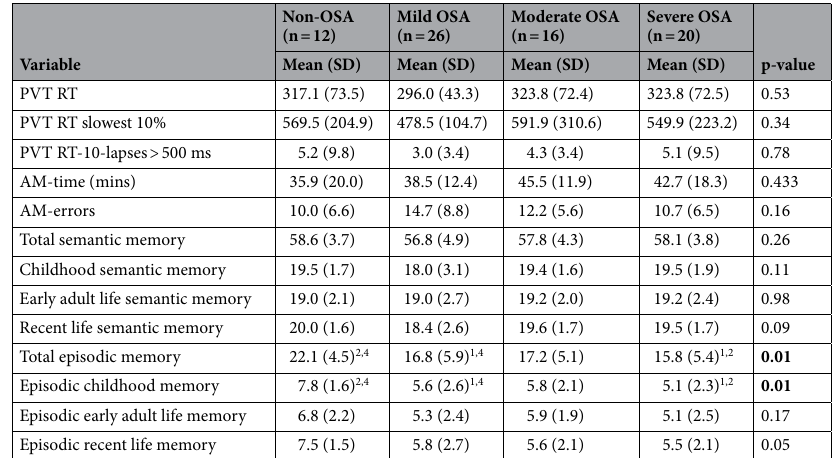
Table 2. Comparison of cognitive tests by OSA severity group. OSA severity cut-off values were: 5–14 AHI (mild); 15–29 AHI (moderate); ≥ 30 AHI (severe); Significant differences between groups were defined by: 1 p < 0.05 vs. non-OSA; 2 p < 0.05 vs. mild OSA; 3 p < 0.05 vs. moderate OSA; 4 p < 0.05 vs. severe OSA; PVT, psychomotor vigilance test; RT, reaction time; AM, Austin Maze; ms, milliseconds. Bolded p-values indicate statistically significant effects